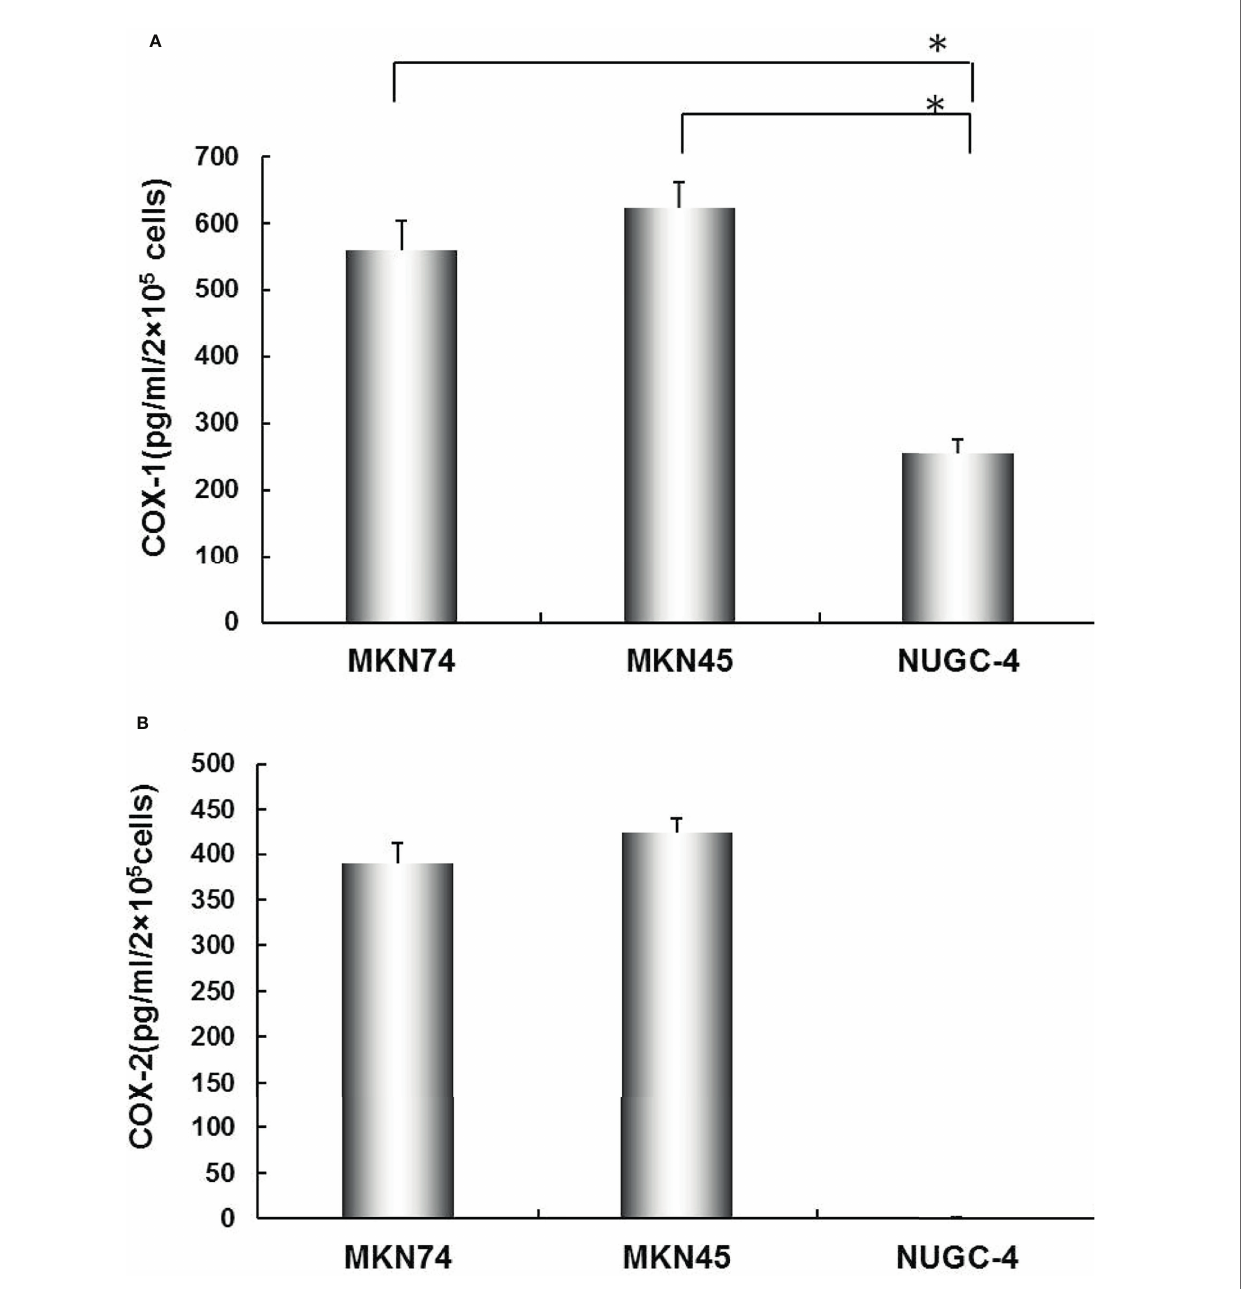
FIGURE 2 | The secreted levels of COX-1 (A) and COX-2 (B) in gastric cancer cell lines. COX-1 and COX-2 protein concentration in MKN74, MKN45, and NUGC-4 cell culture medium was determined by ELISA. The values are expressed as mean ± SD. Multiple comparisons were analyzed by one-way ANOVA followed by Student-Newman-Keuls test; * p < 0.01. This experiment was carried out in